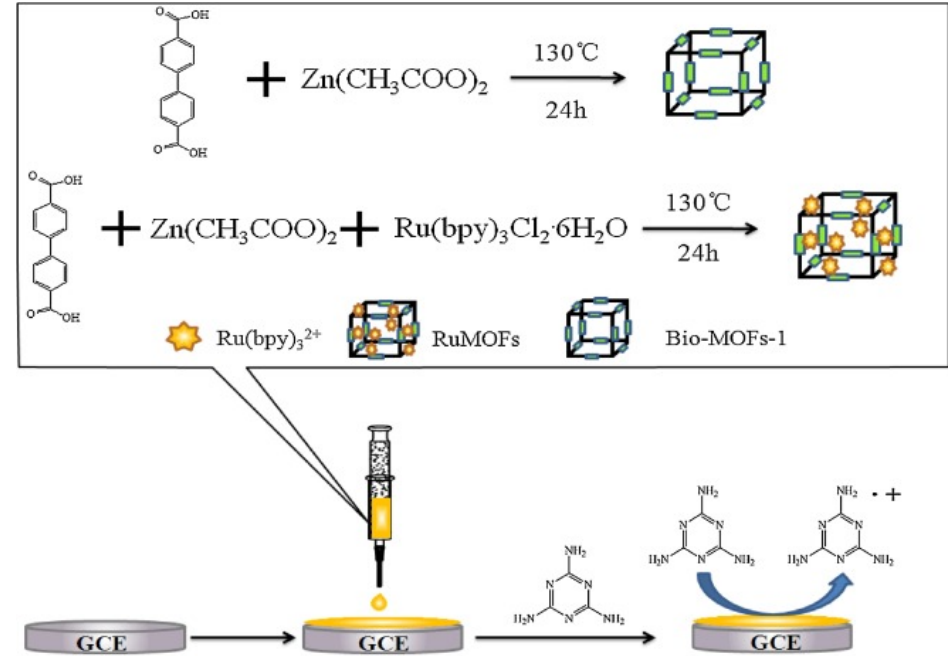
Figure 6. Design process of the ECL sensor for melamine detection in dairy products [247]. Copyright permission has been obtained.